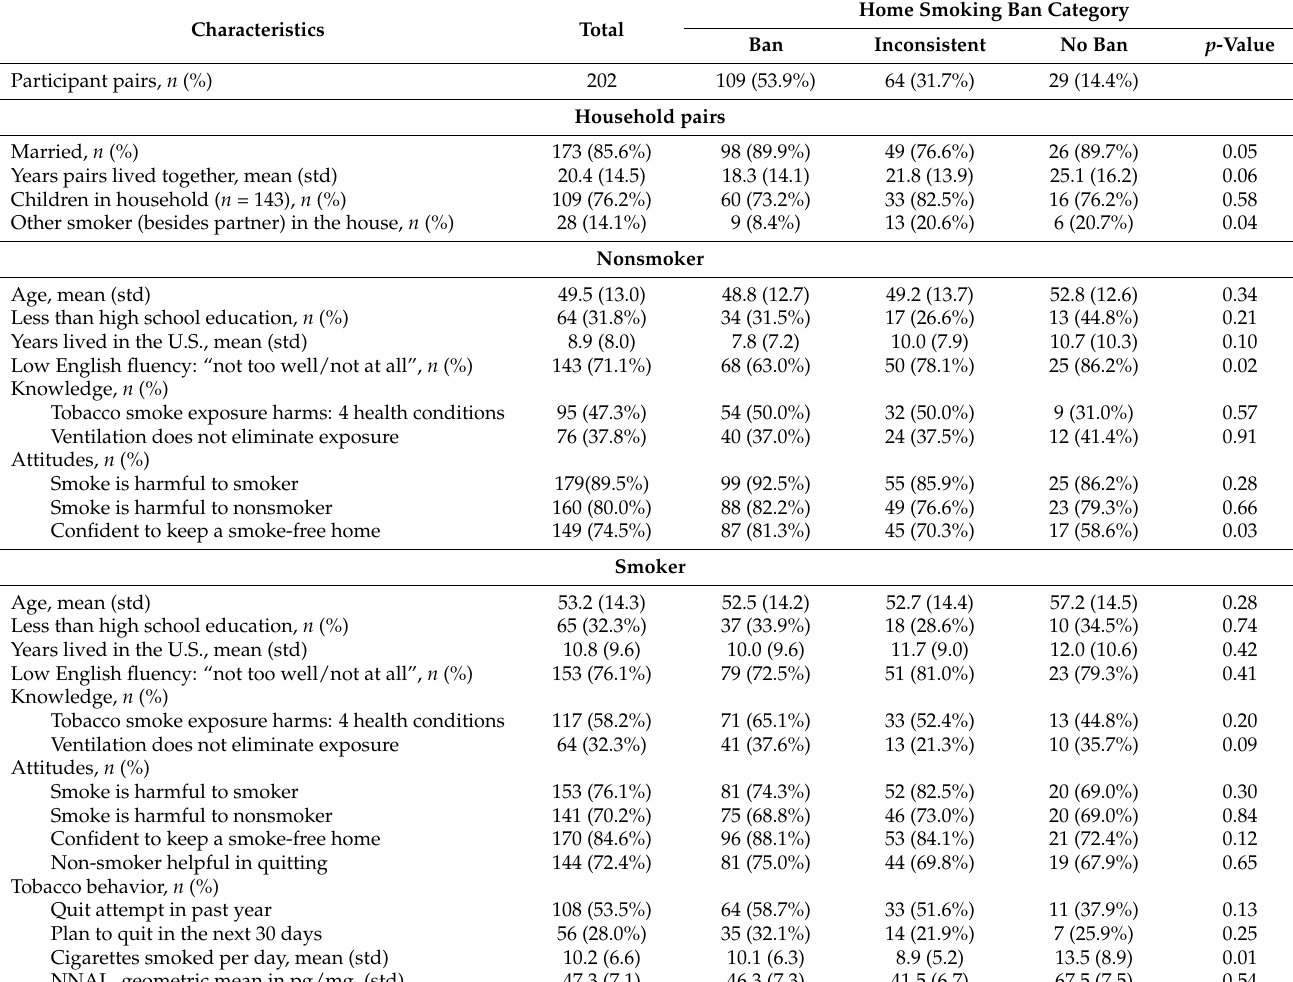
Table 1. Characteristics of Chinese American nonsmoker and smoker household pairs by home smoking ban category.